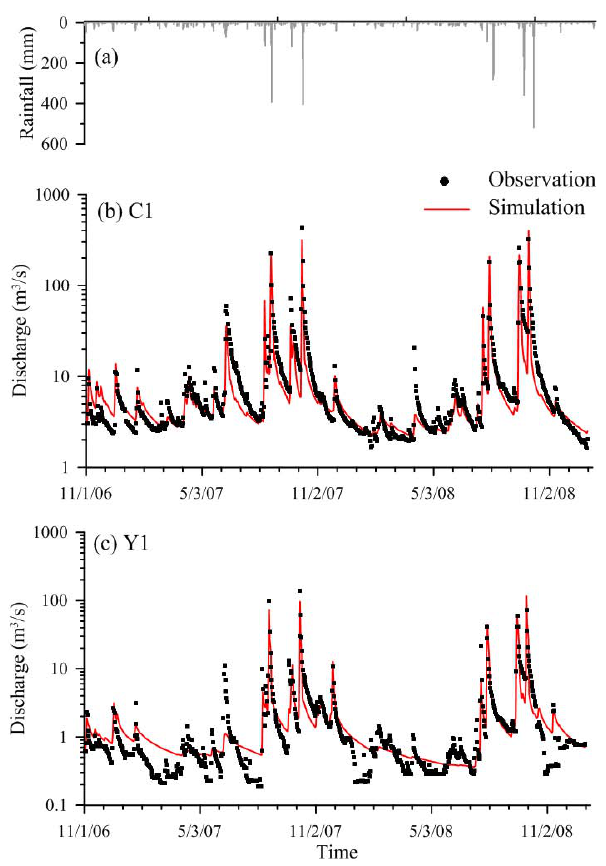
Fig. 2. The time series data of rainfall and discharge during the study period. The rainfall hyetograph from 1 November 2006 to 31 December 2008 is shown in panel (a) . The observed and simu- lated discharge in C1 and Y1 are shown in panels (b) and (c) , re- spectively. The black dots represent the observed discharge and the red lines stand for the